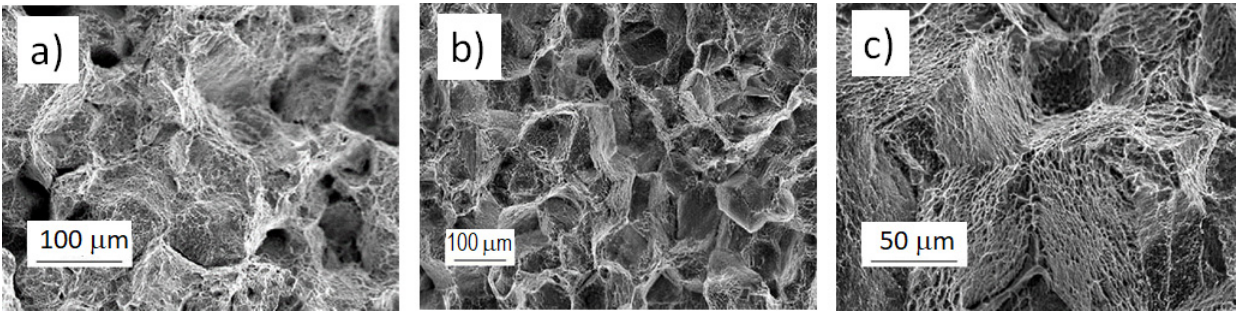
Figure 10. ( a ) Steel 3A (V-free) solution-treated and strained at 800 °C, ( b , c ) Steel 5A (0.21 wt.% V) solution-treated and strained at 762 °C.